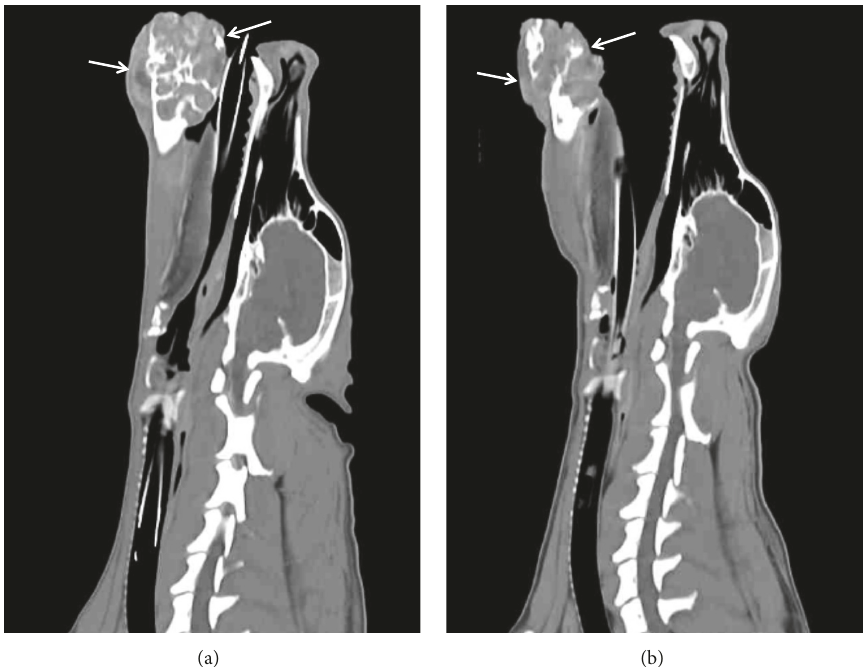
Figure 6: Sagittal views of computed tomography (CT) were obtained before study (a) and one month after the last treatment (b). Tumor shrinkage was